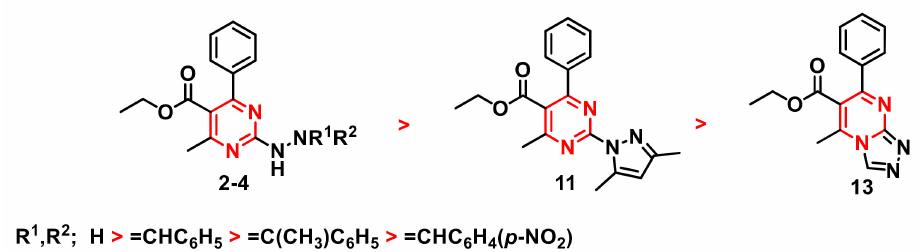
Figure 6. Summarized SAR pattern of the Biginelli-derived pyrimidine and fused pyrimidine